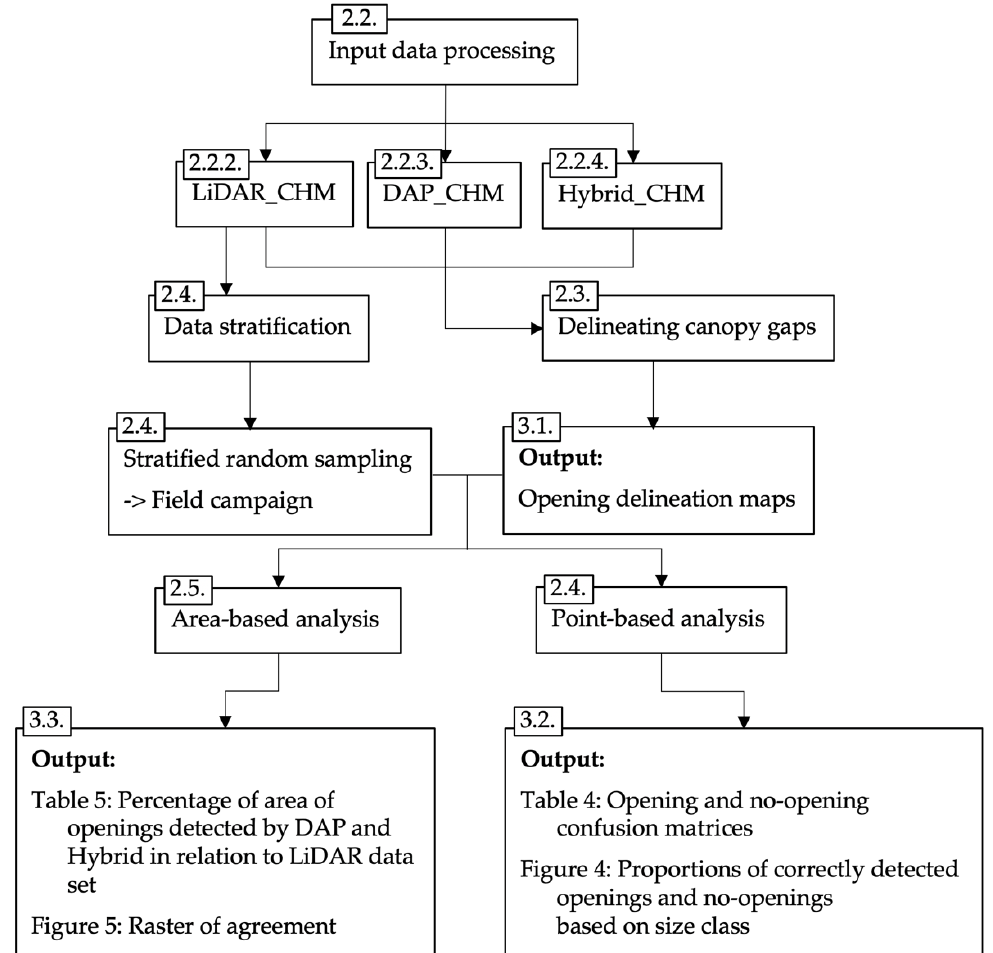
Figure 1. Workflow chart depicting the steps performed in this study, with numbers referring to the corresponding subsections of this paper. Two point clouds—digital aerial photogrammetry (DAP) and light detection and ranging (LiDAR) served as the basis for the derivation of three canopy height model (CHM) alternatives: LiDAR (LiDAR_CHM), DAP (DAP_CHM), and a LiDAR-DAP hybrid (Hybrid_CHM). Evaluation data was generated during a field campaign. Both an area-based as well as a point-based analysis of the resulting opening were performed. Detailed flowcharts for the data processing using LAStools are provided in the supplementary material.